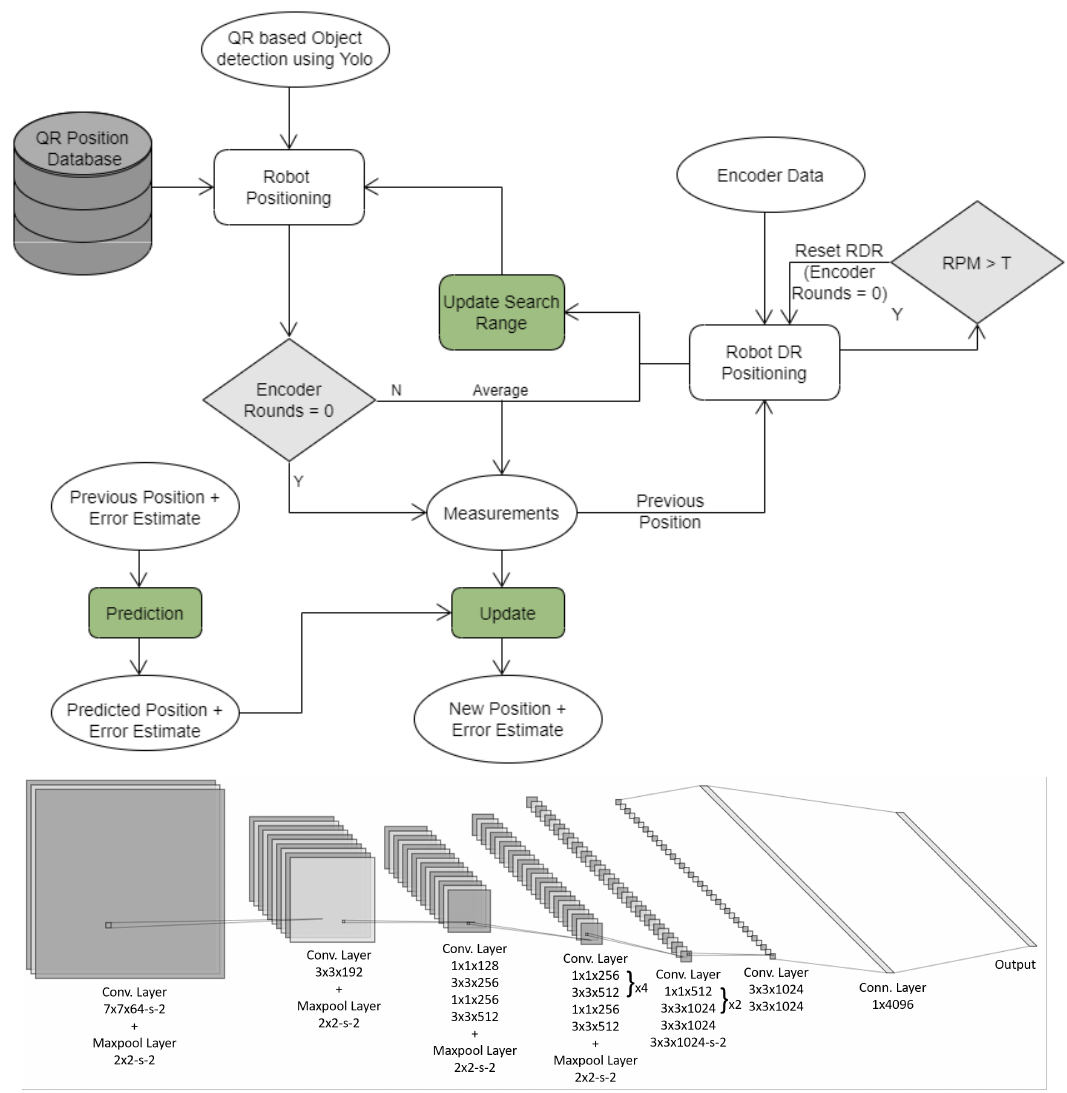
Figure 7. Top: Flow chart of QR-based robot positioning [29] with QR codes instead of radio beacons, round counting instead of steps counting, and the addition of a Kalman filter. Bottom: Used YOLOv2 QR code